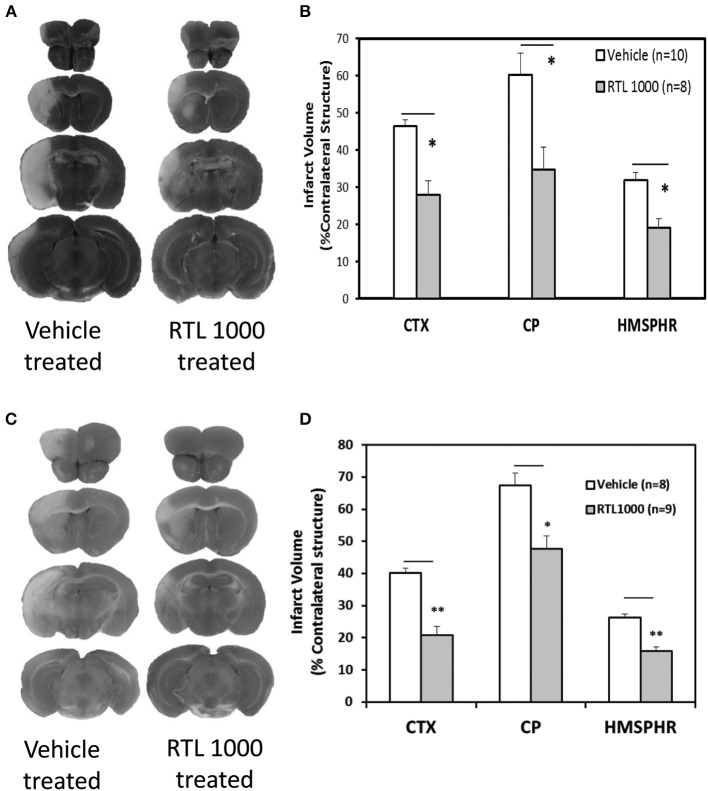
RTL1000 reduces infarct volume in young and older mice. Transient MCAO (60 min) male mice were treated with 100 μl vehicle or 100 μg RTL1000 given S.C. at 4, 24, 48, and 72 h after MCAO. Brains were harvested 96 h after MCAO and brain slices were stained with 2,3,5-triphenyltetrazolium chloride (TTC) (A,C). Infarct volumes were measured as percentage of contralateral structure in young (B) and older mice (D). * Indicates p < 0.05 and ** indicates p < 0.01 compared with vehicle group by Two-Way ANOVA.